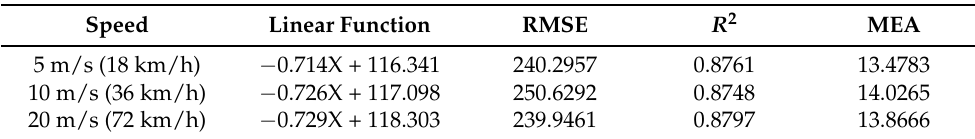
Table 8. The effect of the flight terrain on the performance; the results are presented for location #2 and an altitude of 100 m, at various speeds.